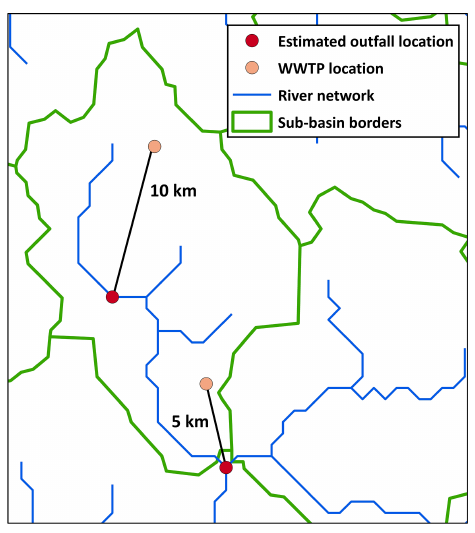
Figure 2. Example of georeferencing process to assign WWTP ef- fluent outfall locations. See text for more